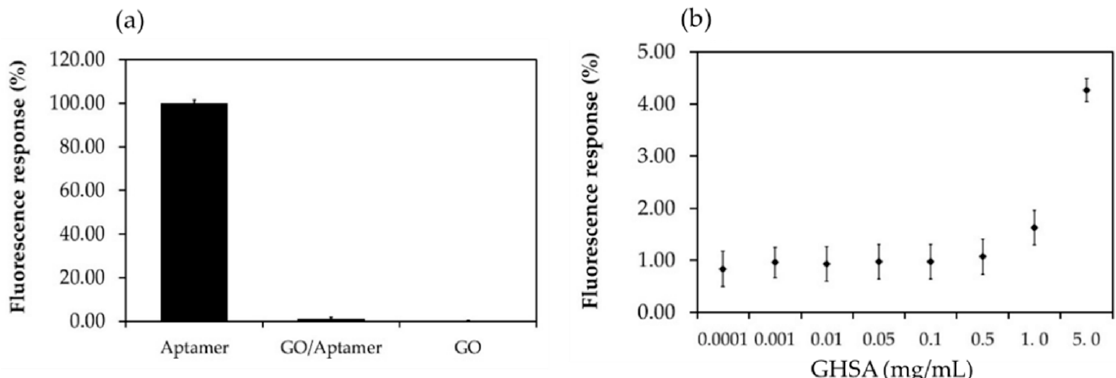
Figure 4. Percent fluorescence response of the components in the electrochemical aptasensor system. ( a ) Percent fluorescence response of the fluorescence-labeled aptamer (Aptamer), GO-aptamer complex (GO-aptamer), and free GO (GO). ( b ) Correlation between the percent fluorescence response and GHSA concentration (0.0001–5 mg/mL). The fluorescence signals were measured at an excitation wavelength of 480 nm and emission wavelength of 520 nm.